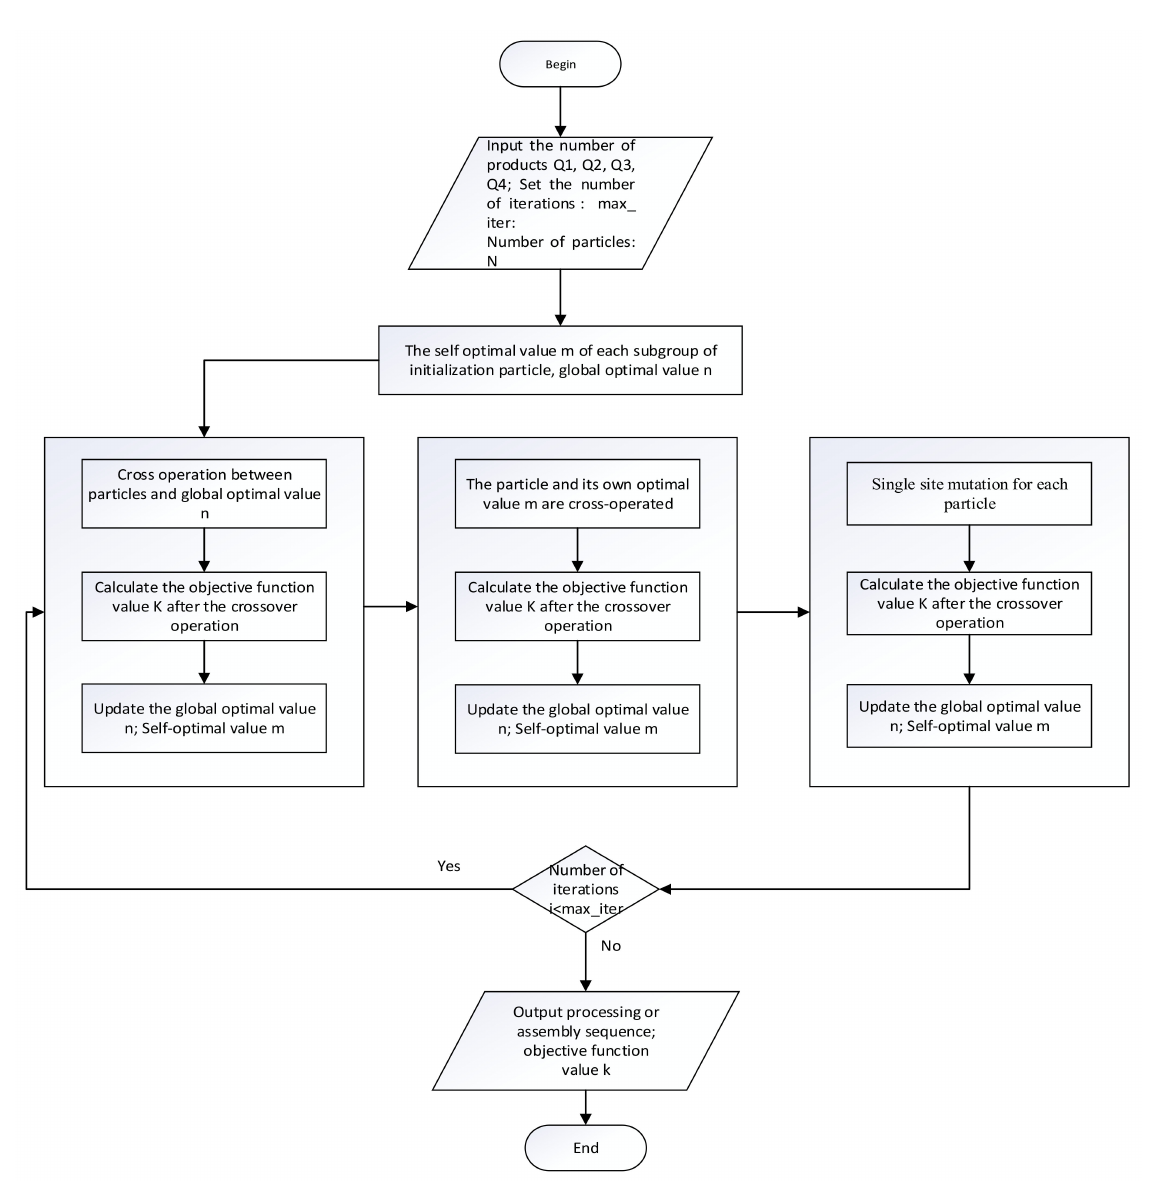
Figure 2. The main process of parallelized hybrid particle swarm